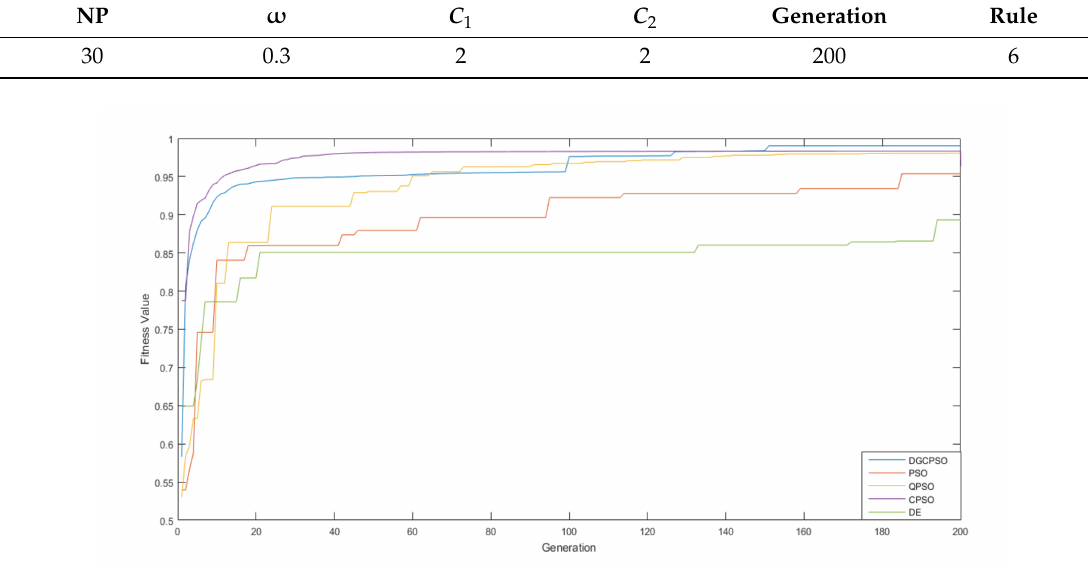
Figure 12. Learning curves of chaotic